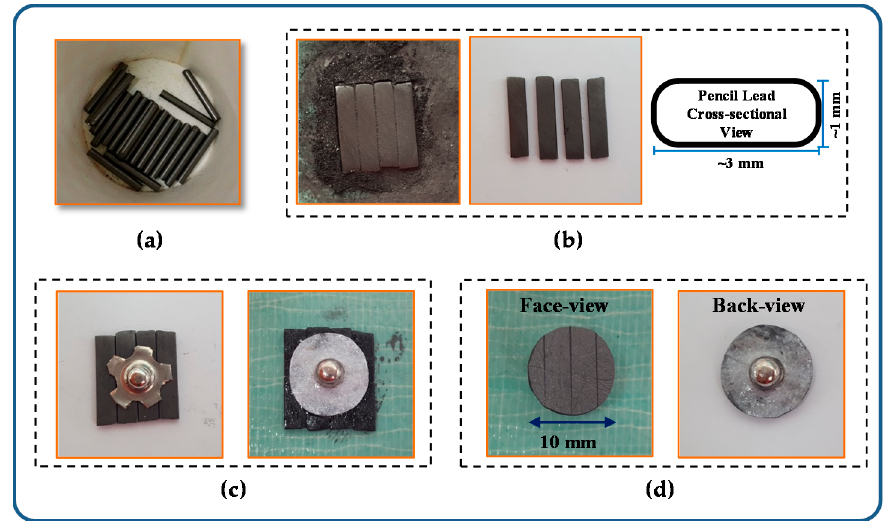
Figure 2. ( a ) Pencil leads; ( b ) Flattened pencil leads; ( c ) Each lead and the metal cap attached using a